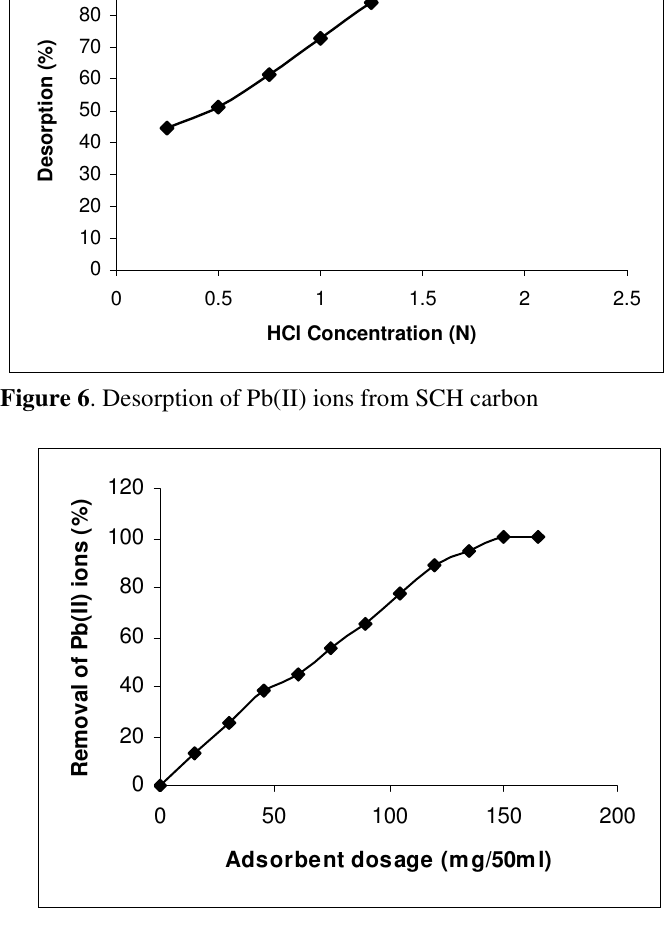
Figure 7 . Effect of SCHC dosage on the adsorption of Pb(II) ions from radiator manufacturing industry waste